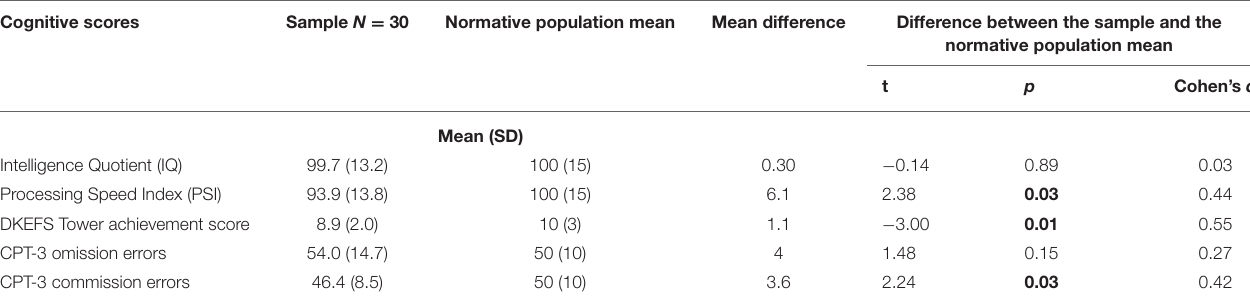
TABLE 3 | Cognitive scores of POMS2b paediatric participants at baseline before randomisation. Cognitive scores Sample N = 30 Normative population mean Mean difference Difference between the sample and the